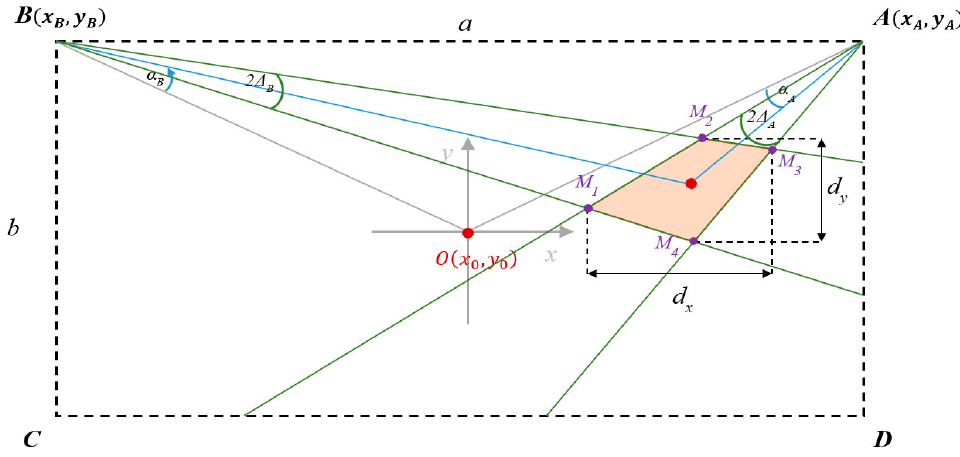
Figure 4. Graphical interpretation of the AoA uncertainty.